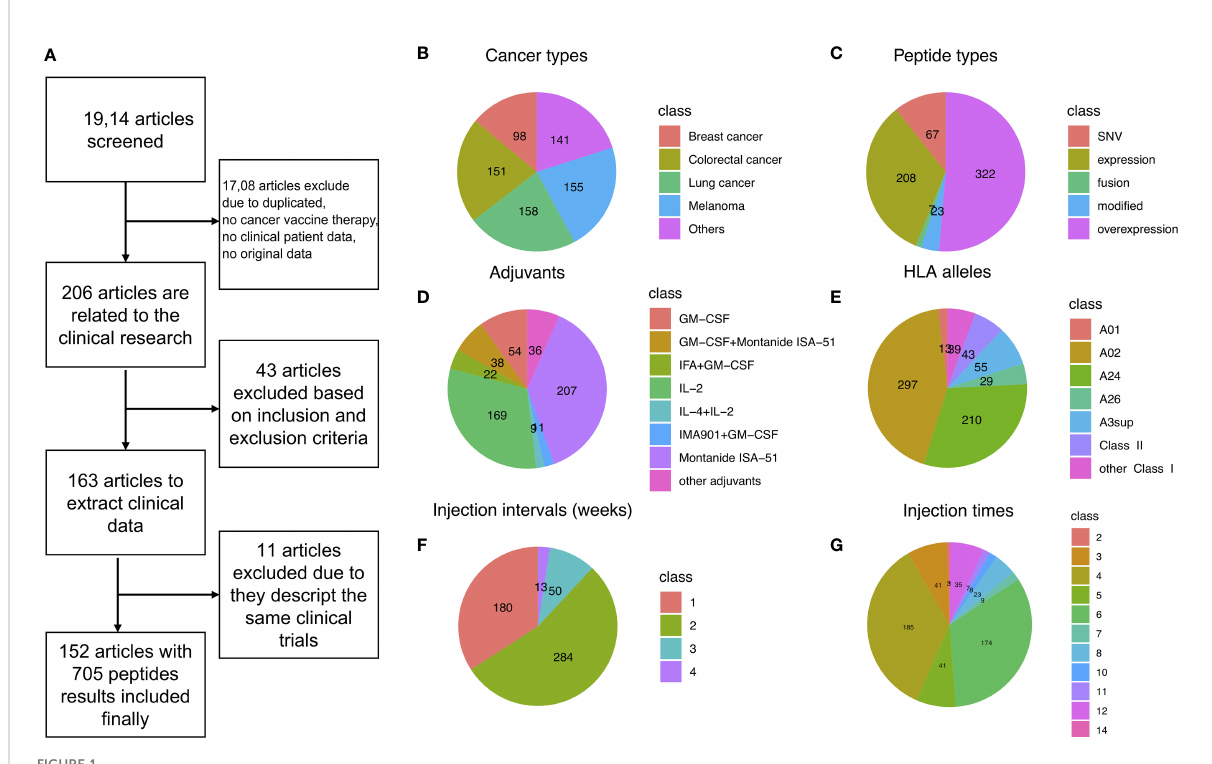
FIGURE 1 Data fi ltering summary landscape of the library, CancerVaccine (https://peptidecancervaccine.weebly.com/). (A) Data fi ltering process. (B) The landscape of cancer types. (C) The landscape of peptide types. (D) The landscape of adjuvants. (E) The landscape of HLA alleles. (F) The landscape of treatment regimen (injection interval). (G) The landscape of treatment regimen (injection